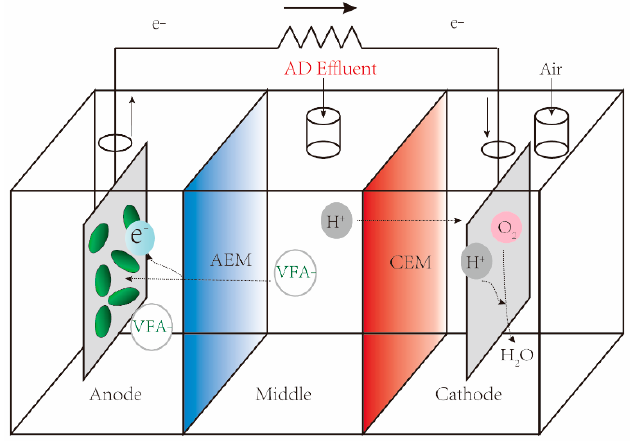
Figure 3. Schematic MFC-based VFA biosensor with three chambers. AEM: anion exchange membrane; CEM: cation exchange membrane.